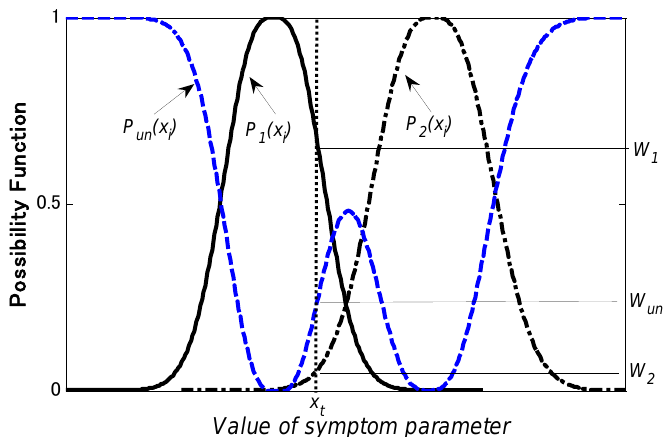
Figure 8. Matching examples of possibility